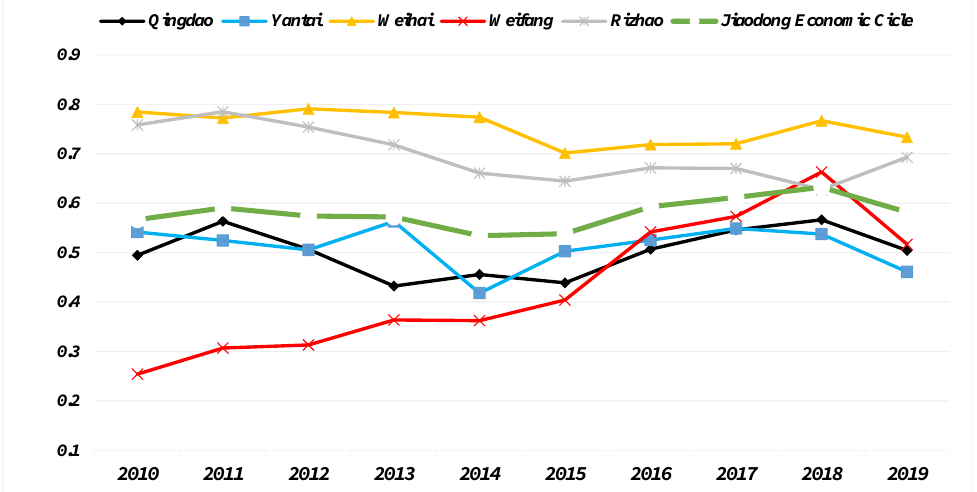
Figure 6. Timeseries of the comprehensive Urban environment level of 5 cities and the entire Jiaodong Economic Circle.